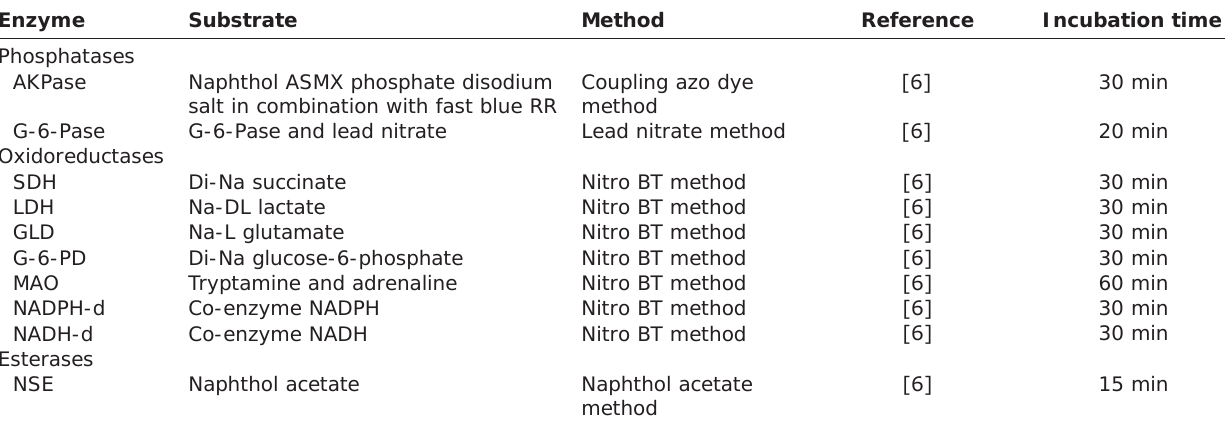
Table-1: Histoenzymatic methods used on cryostat sections of submandibular salivary glands of buffalo fetuses. Enzyme Substrate